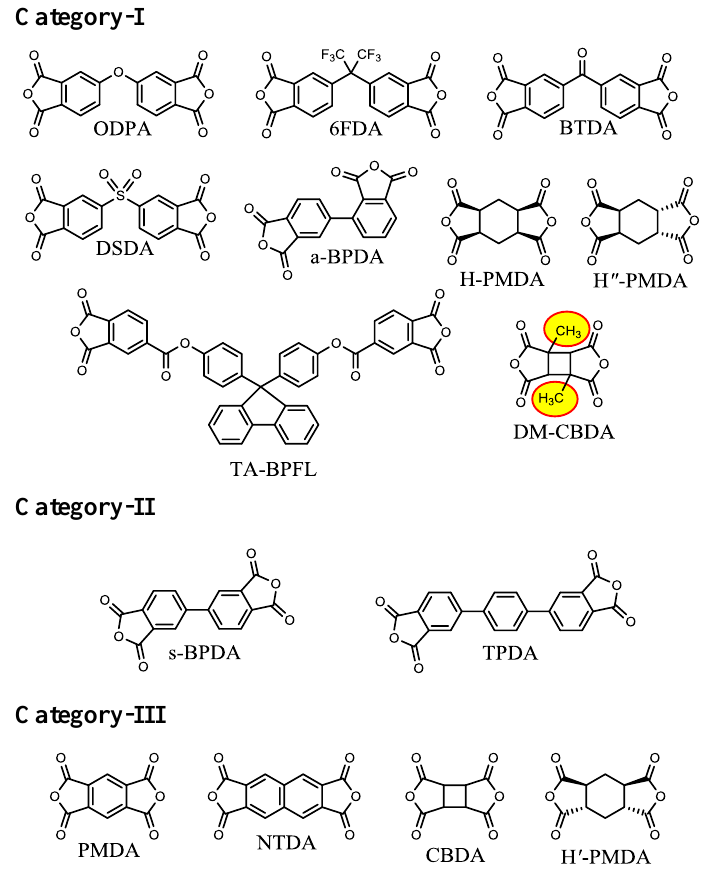
Figure 10. Classification of tetracarboxylic dianhydrides on the basis of the polymerizability with trans -1,4-CHDA in DMAc. Reproduced with permission from Elsevier [37].